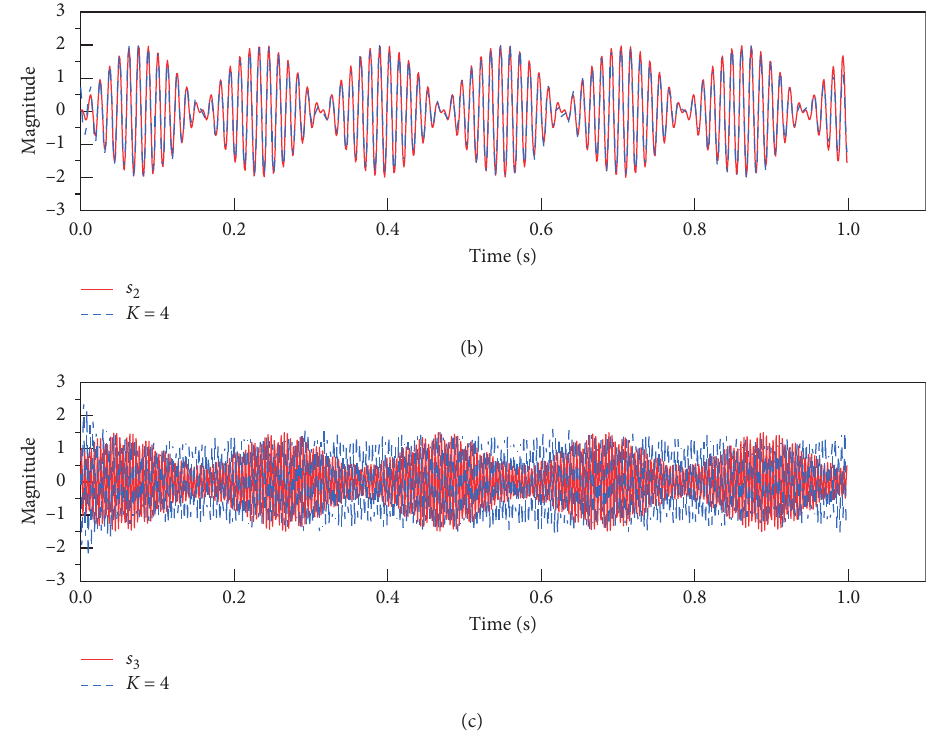
Figure 11: The comparison results of estimated source signals and original signals with parameter K . Table 1: The correlation comparison of estimated source signals with mode parameter K .